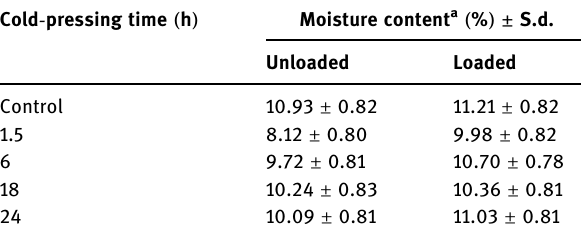
Table 6: Average value of moisture content